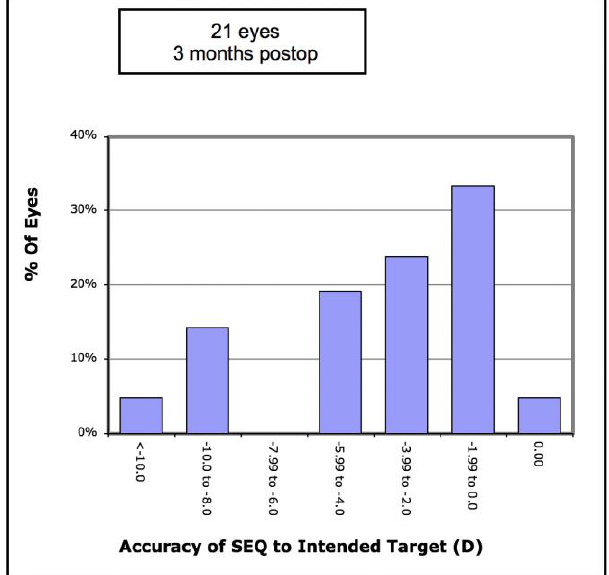
Figure 7. Accuracy of attempted versus achieved spherical equivalent (SEQ) in 21 keratoconic eyes implanted with Ferrara corneal ring segments.